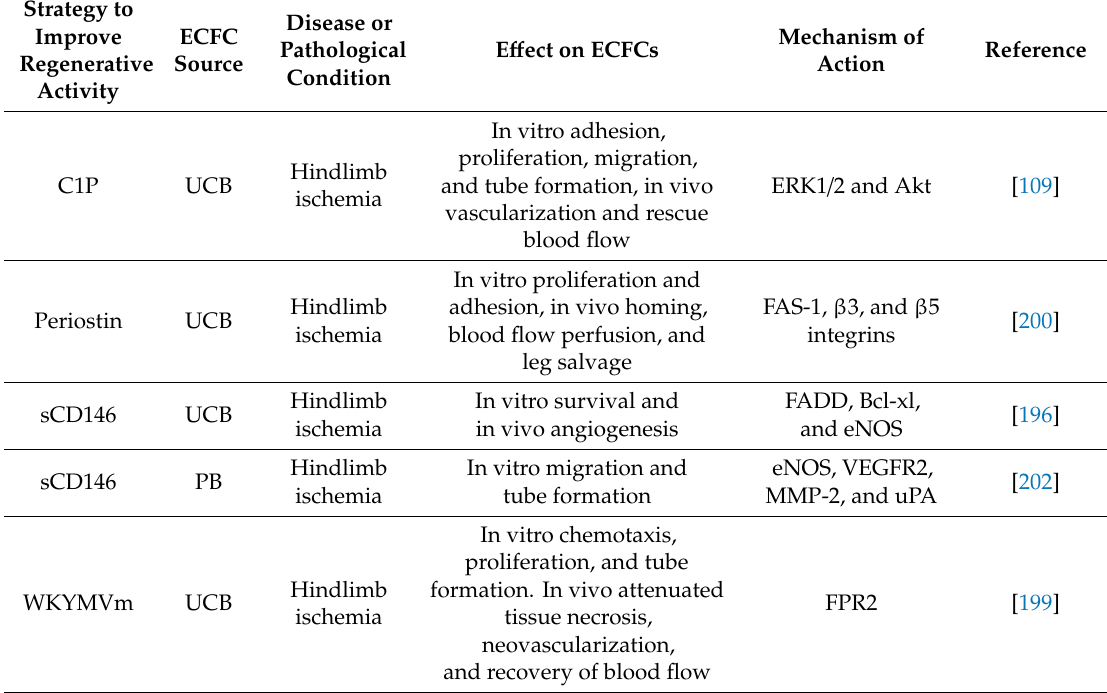
Table 5. Strategies to stimulate ECFC homing to sites of neovessel